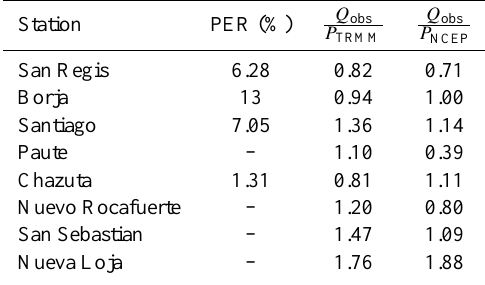
Table 3. Data uncertainty and water balance closure calculated at the hydrological stations. PER=probable error range; Q obs : ob- served streamflow; P : precipitation. Time domain: